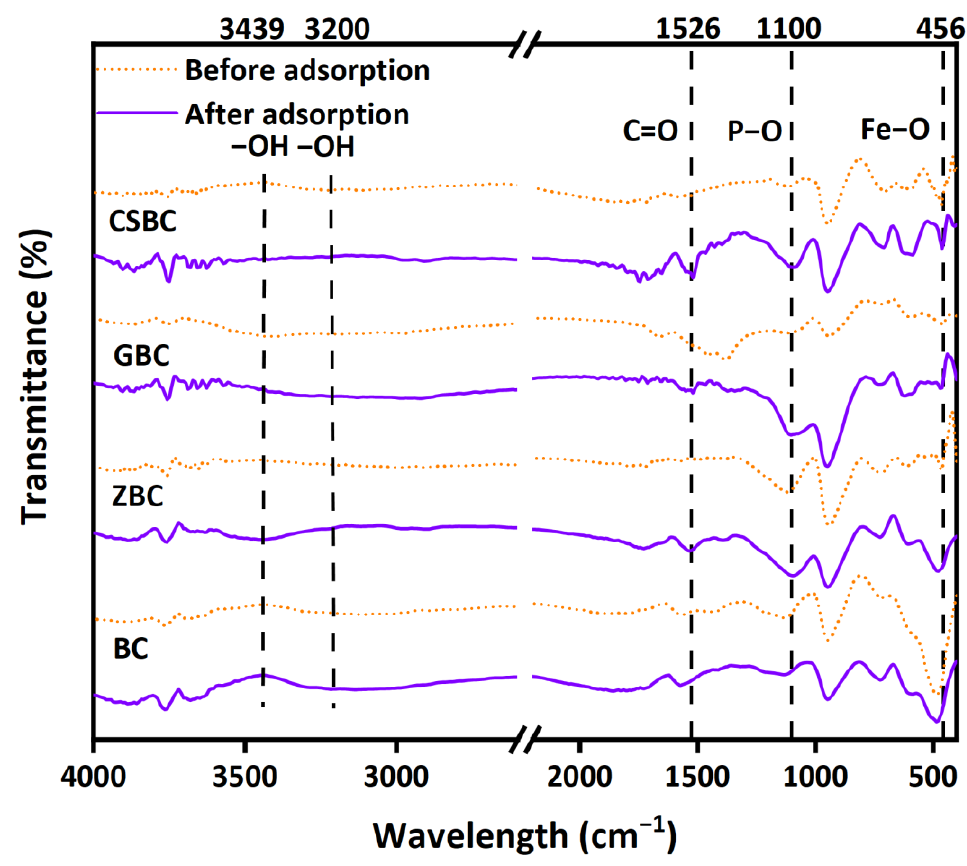
Figure 10. FTIR spectra of BC, CSBC, GBC, and ZBC, before and after P adsorption. The peaks near 3200 and 3439 cm − 1 are due to the stretching vibration of the -OH bond, which is associated with the Fe hydroxyl on the Fe oxides surface (Figure 10). Moreover, the bands near 1100 cm − 1 occur due to the stretching vibration of the P-O bond [48]. The strengthening peaks of the P-O bonds and the disappearance of the -OH bond after the P adsorption indicate the ligand exchange via the adsorption replacing the hydroxyl groups, which are more obvious for GBC in this study. The results of XPS supported that FeOOH (goethite), which has a good affinity to PO 43 − , was successfully loaded on GBC before P adsorption, with a binding energy of 727.24 eV [21]. The weakening of the peaks of the Fe 2p spectrum of the adsorbed GBC also confirmed that FeOOH plays an important role in the adsorption process of PO 43 − (Figure 11i)